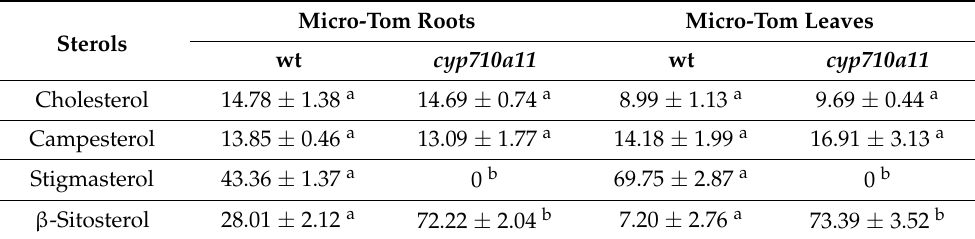
Table 2. Gas chromatography – mass spectrometry analysis of the free sterol compositions of the roots and leaves from the tomato cv. Micro-Tom wt and cyp710a11 mutant infected with M. incog- nita . Samples were taken at 28 dpi.